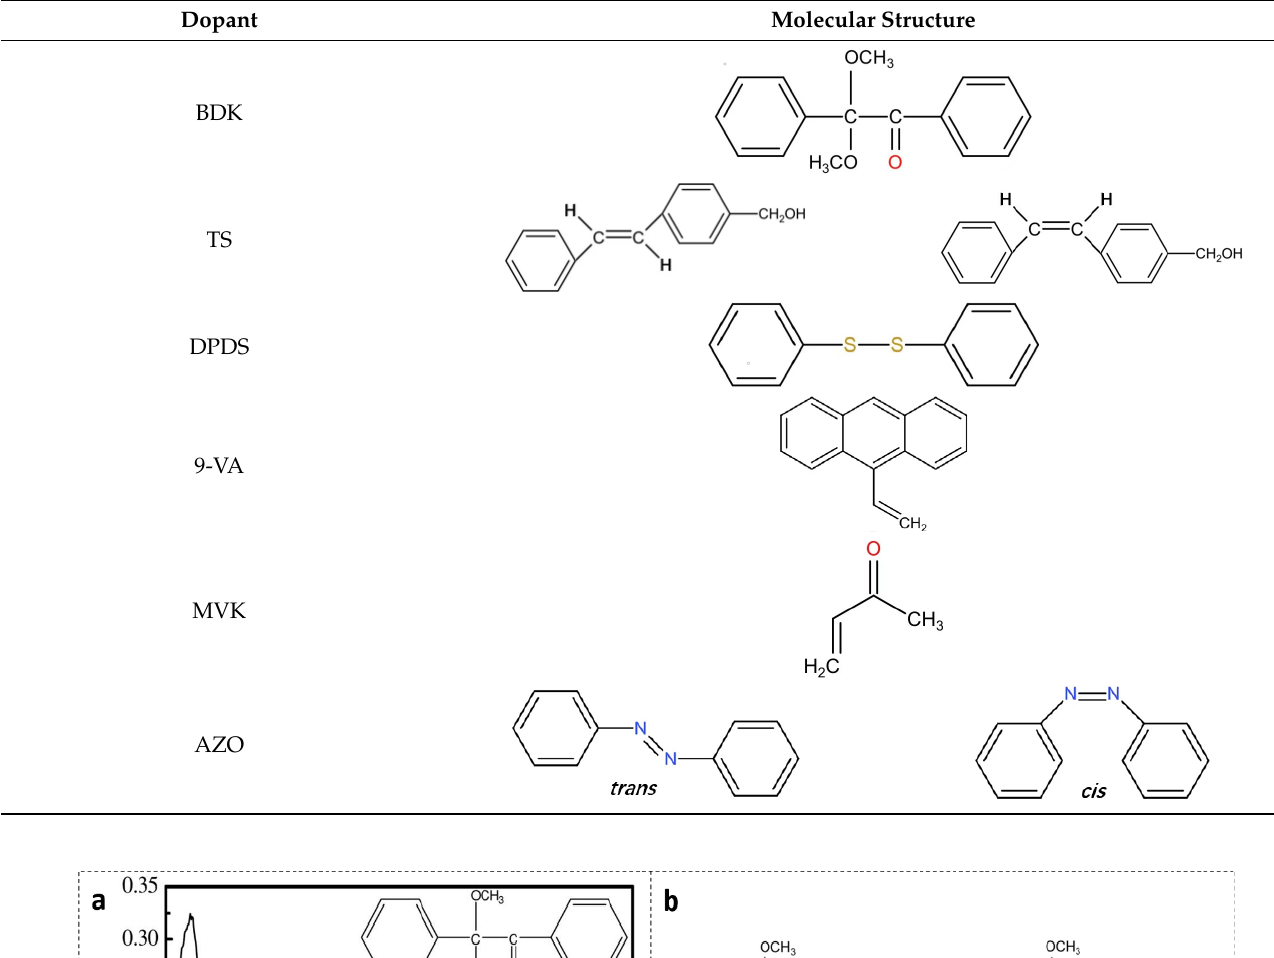
Table 1. The structure of dopants.